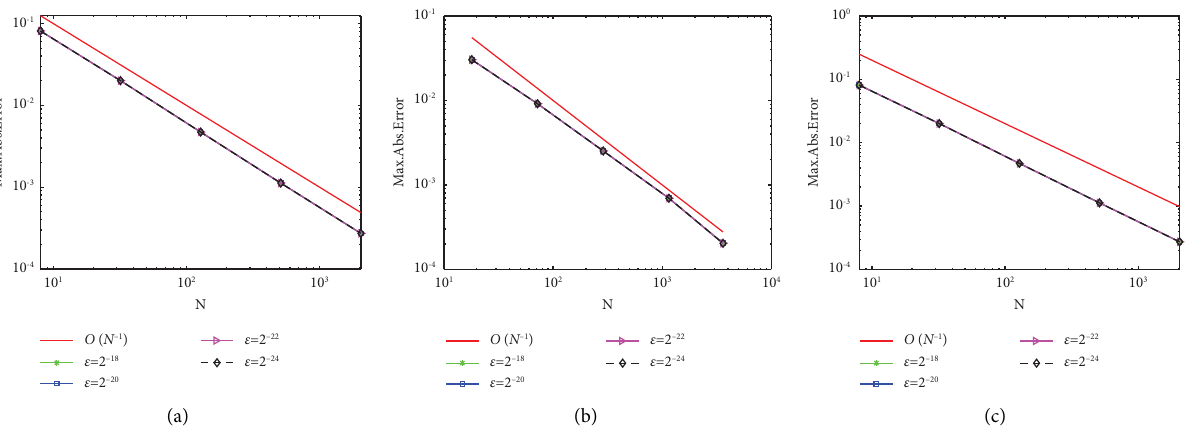
Figure 7: Log-log plots of N versus maximum absolute error for (a) Example 1, (b) Example 2, and (c) Example